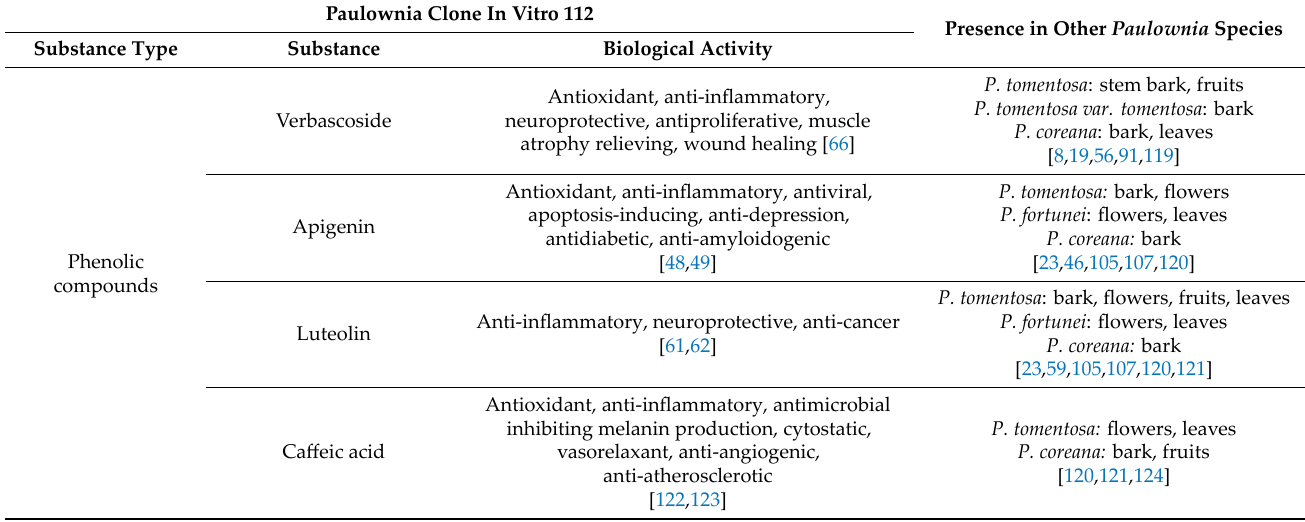
Table 4. Substances isolated from Paulownia Clone in vitro 112, their biological activity, and their presence in other species of Paulownia